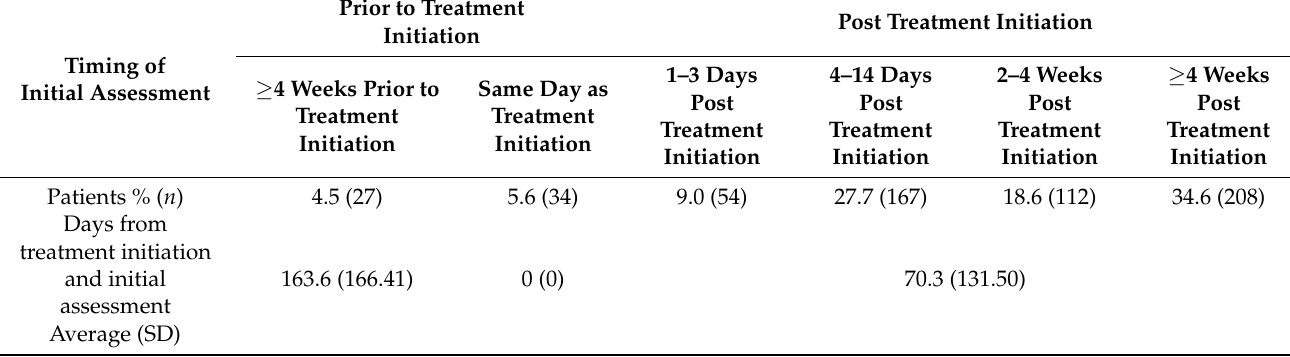
Table 2. Timing of initial assessment in relation to treatment initiation ( n = 602).